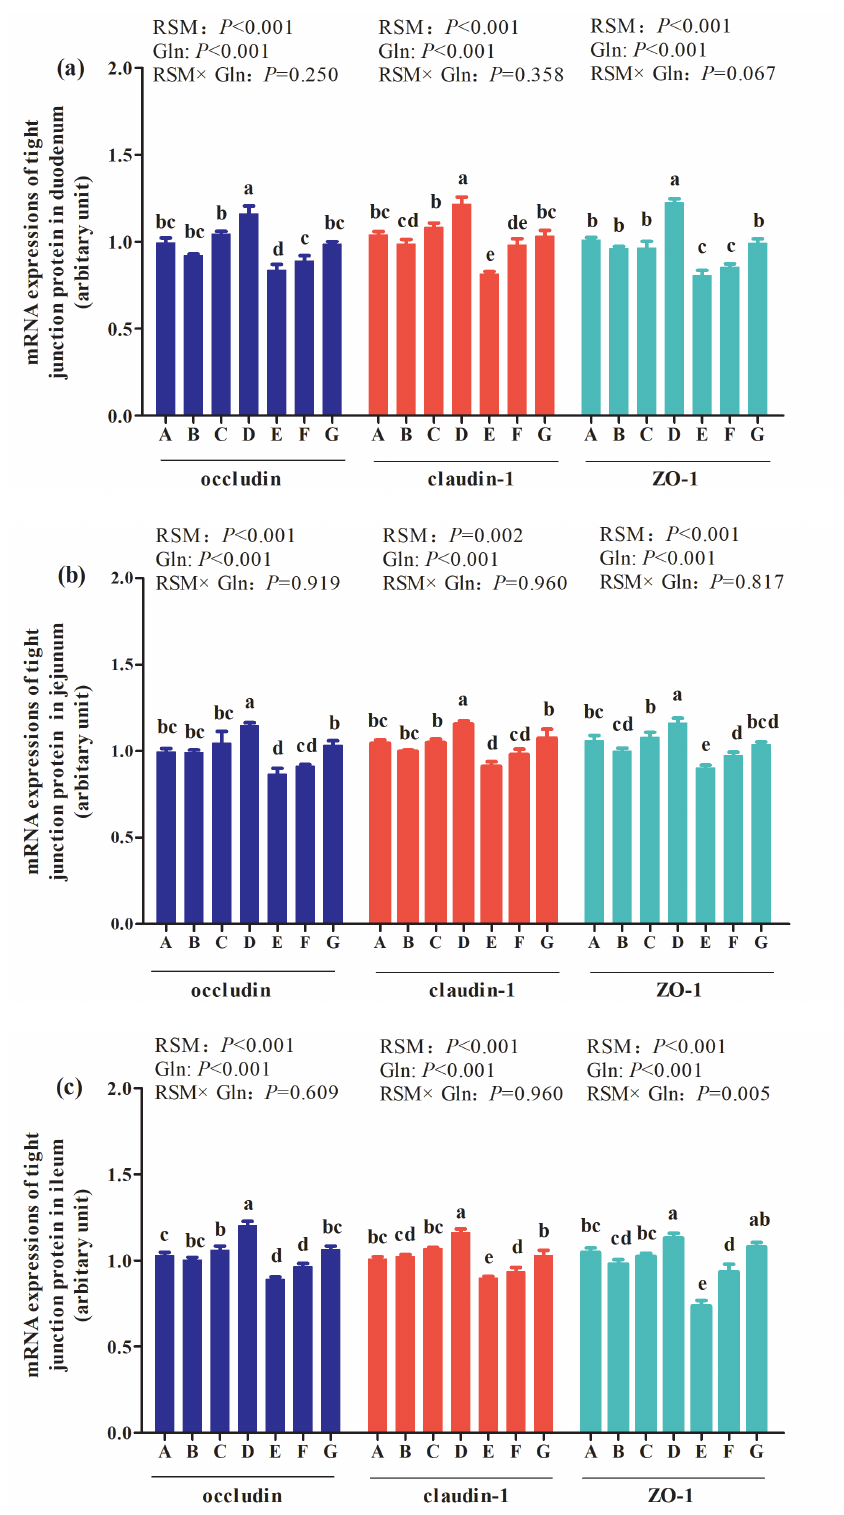
Figure 4. Effects of different levels of rapeseed meal substitution and glutamine on mRNA expression of intestinal tight junction protein of Qian- dongnan Xiaoxiang Chicken at 42 days of age (n = 10 per treatment group). Columns in the same color with different small letters superscripts mean significant differences (p<0.05). Broilers in the control group (A) were fed with basal diet. Broilers in 10% (B) and 20% RSM (E) were fed with diet containing 10% or 20% RSM, respectively. 10% RSM+0.5% Gln (C), 10% RSM+1.0% Gln (D), 20% RSM+0.5% Gln (F), and 20% RSM+1.0% Gln (G) mean that 0.5% Gln or 1% Gln was separately supplemented based on 10% and 20% RSM